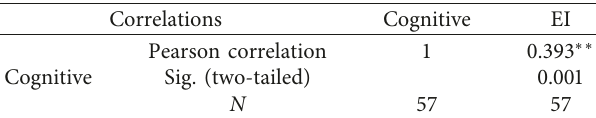
Table 5: The relationship between emotional intelligence and cognitive strategy use scores.